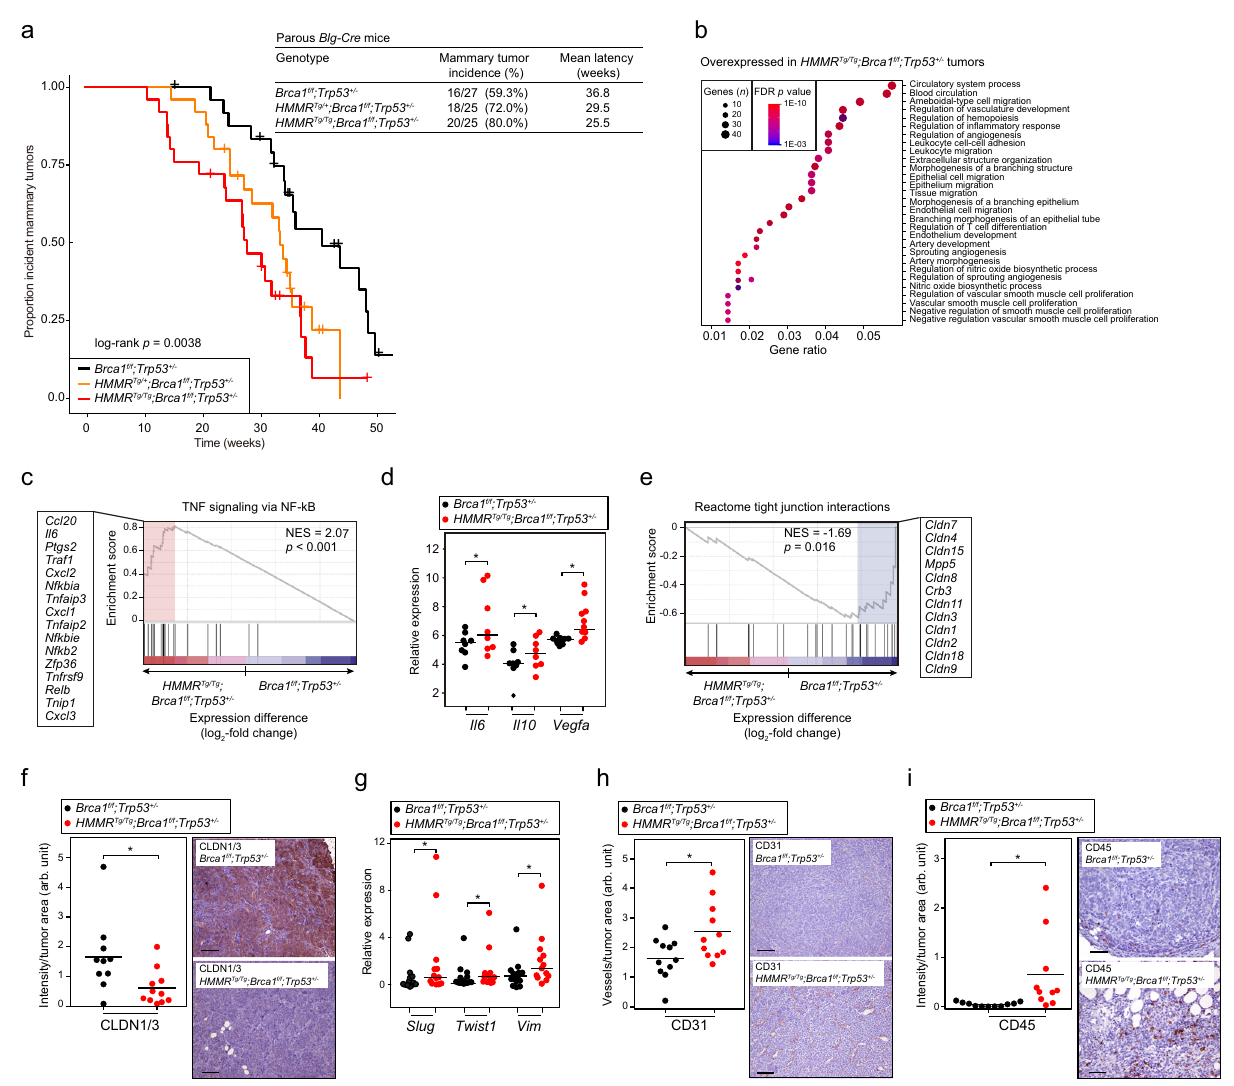
Fig. 3 HMMR overexpression increases Brca1 -mutant mammary tumorigenesis, and modi fi es the cancer cell phenotype and tumor microenvironment. a Left panel, Kaplan – Meier curves of mammary tumor incidence in mice divided into three genotype groups that differ by HMMR transgene status, as depicted in the inset. All mice were carriers of Blg-Cre , whose expression was induced by two rounds of pregnancy. Right top panel, table with details of the number of animals studied of each genotype, incidence of tumors, and mean latency. b Overrepresented (false discovery rate (FDR) < 1%; gene set size and FDR value color-coded) GO terms in genes overexpressed in HMMR Tg/Tg ; Brca1 f/f ; Trp53 + / − relative to Brca1 f/f ; Trp53 + / − tumors. c Gene Set Enrichment Analysis (GSEA) results showing overexpression of the “ TNF signaling via NF- κ B ” gene set in HMMR Tg/Tg ; Brca1 f/f ; Trp53 + / − tumors. GSEA was applied adopting standard parameters and using the pre-ranked expression differences (log 2 -fold change) between the two tumor sets; the normalized enrichment score (NES) and associated probability (Kolmogorov-Smirnov statistic and x1000 permutation test) are shown. The red rectangle indicates the overexpressed leading edge, and the corresponding gene names are depicted. d Overexpression of Il6 , Il10 , and Vegfa in HMMR Tg/Tg ; Brca1 f/f ; Trp53 + / − tumors (inset, color-coded) corroborated by semi-qRT-PCR assays. One-tailed Student ’ s unpaired-samples t test; * p = 0.035 ( Il6 ), 0.045 ( Il10 ), and 0.013 ( Vegfa ). Horizontal lines depict the average tumor values ( n = 2 experiments). e GSEA results showing underexpression (Kolmogorov-Smirnov statistic and x1000 permutation test) of genes coding for tight-junction proteins (Reactome pathway) in HMMR Tg/Tg ; Brca1 f/f ; Trp53 + / − tumors. f Quanti fi cation of CLDN1/3 expression by immunohistochemistry assays and representative images of tumor staining in de fi ned groups. Arbitrary units (arb. unit). One- tailed Student ’ s unpaired-samples t test; * p = 0.011. Scale bar = 100 μ m. g Overexpression of Slug , Twist1 , and Vim in HMMR Tg/Tg ; Brca1 f/f ; Trp53 + / − tumors. One-tailed Student ’ s unpaired-samples t test; * p = 0.045 ( Slug ), 0.033 ( Twist1 ), and 0.045 ( Vim ). Horizontal lines depict the average tumor values ( n = 2 experiments). h , i Quanti fi cation (arb. units) of CD31 and CD45 by immunohistochemistry assays, and representative images of tumor staining in de fi ned groups. One-tailed Student ’ s unpaired-samples t test; * p = 0.013 (CD31) and * p = 0.011 (CD45). Scale bar = 100 μ m.